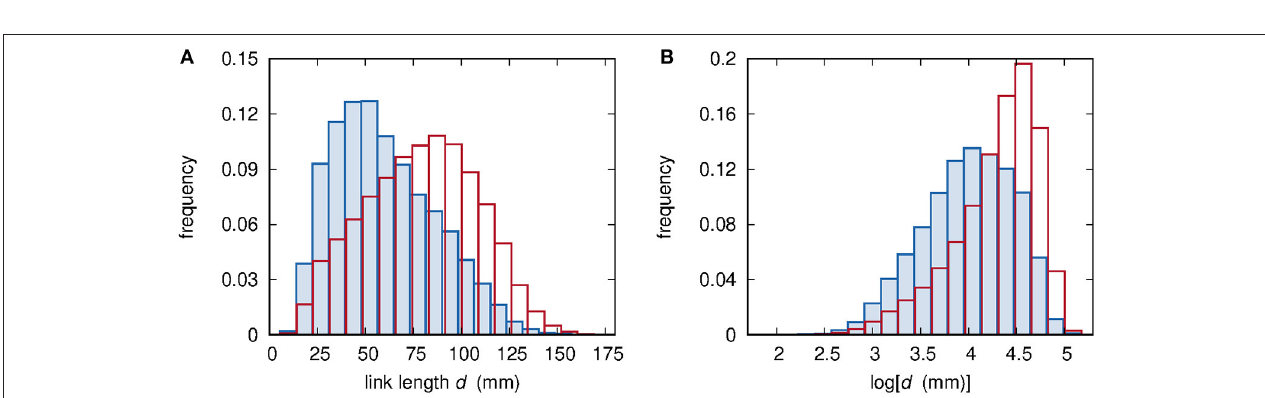
FIGURE 4 | (A) Histograms of the ∼ 250,000 available values of link length d (red lines) and of the ∼ 100,000 values of d corresponding to observable links (blue lines and shaded areas). (B) Histograms of the values of log[ d (mm)]; color meaning is the same as in (A)